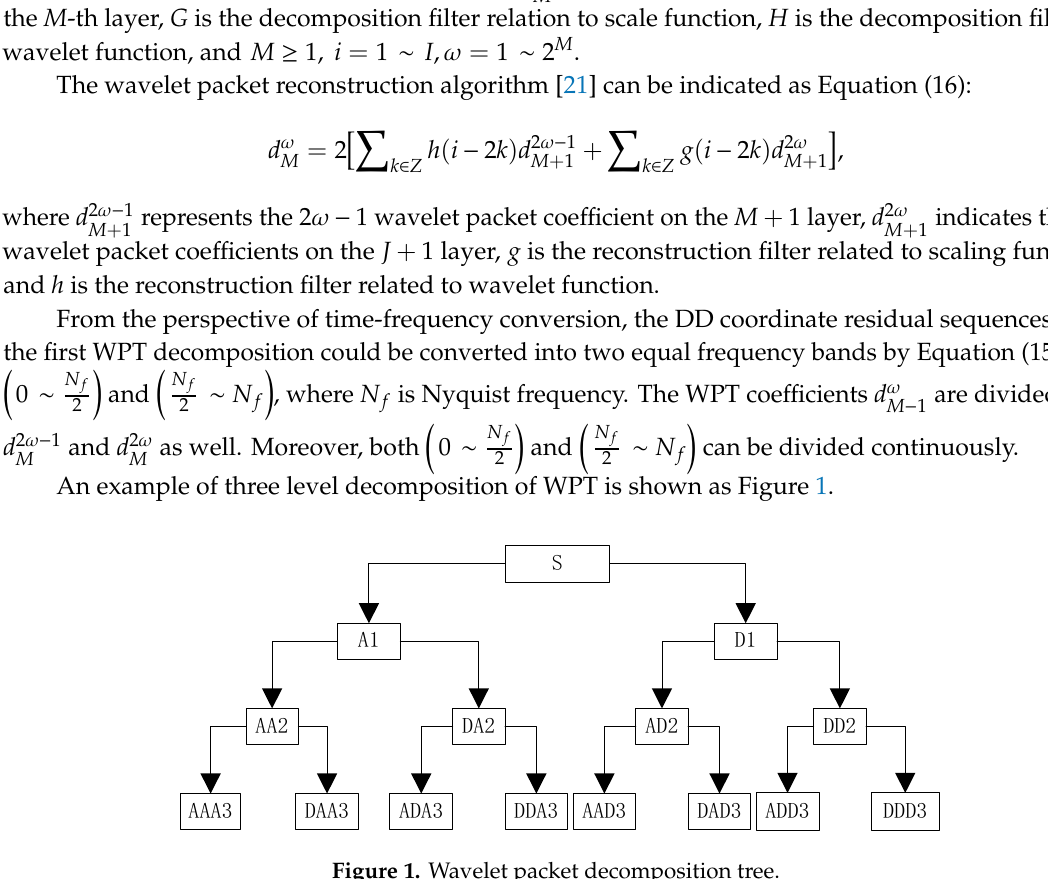
Figure 1. Wavelet packet decomposition tree.